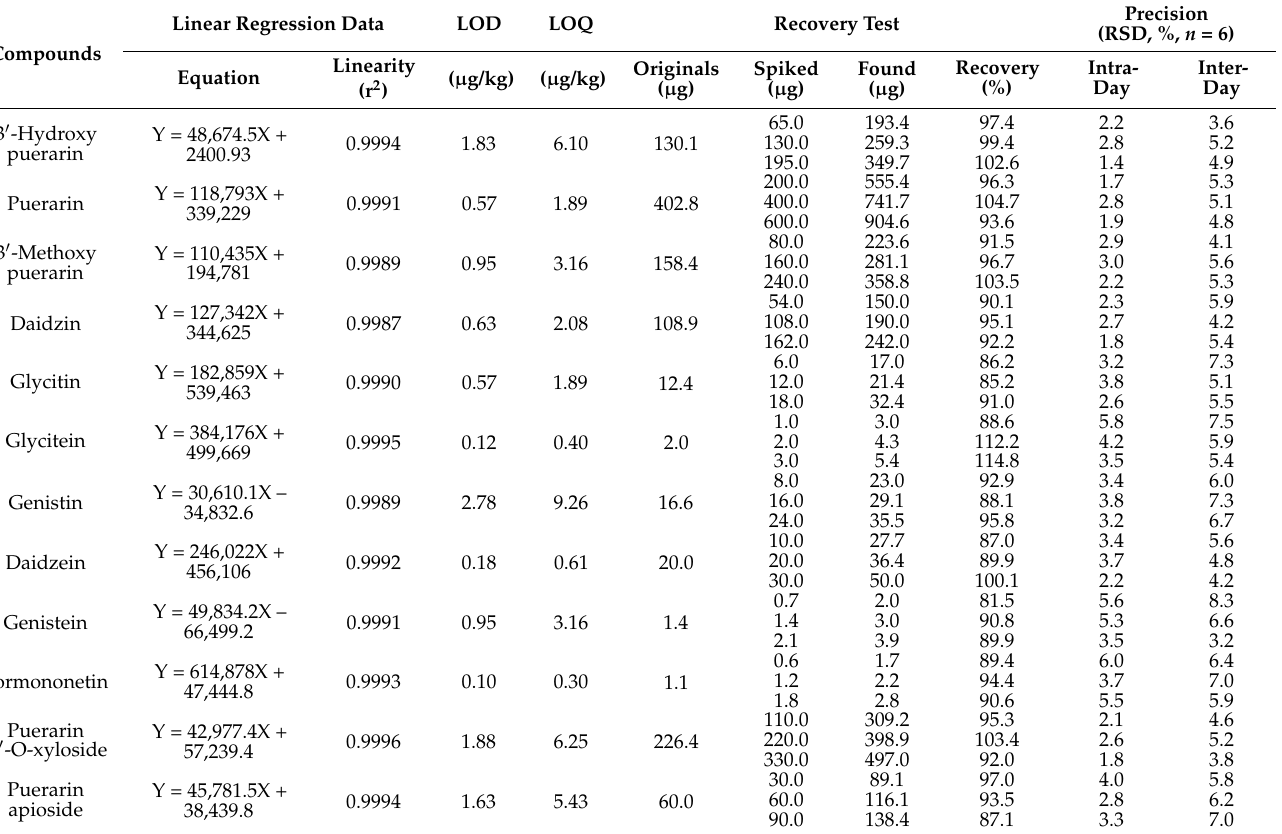
Table 2. Results of Linear regression, LOD, LOQ, recovery test and precision of 12 compounds.